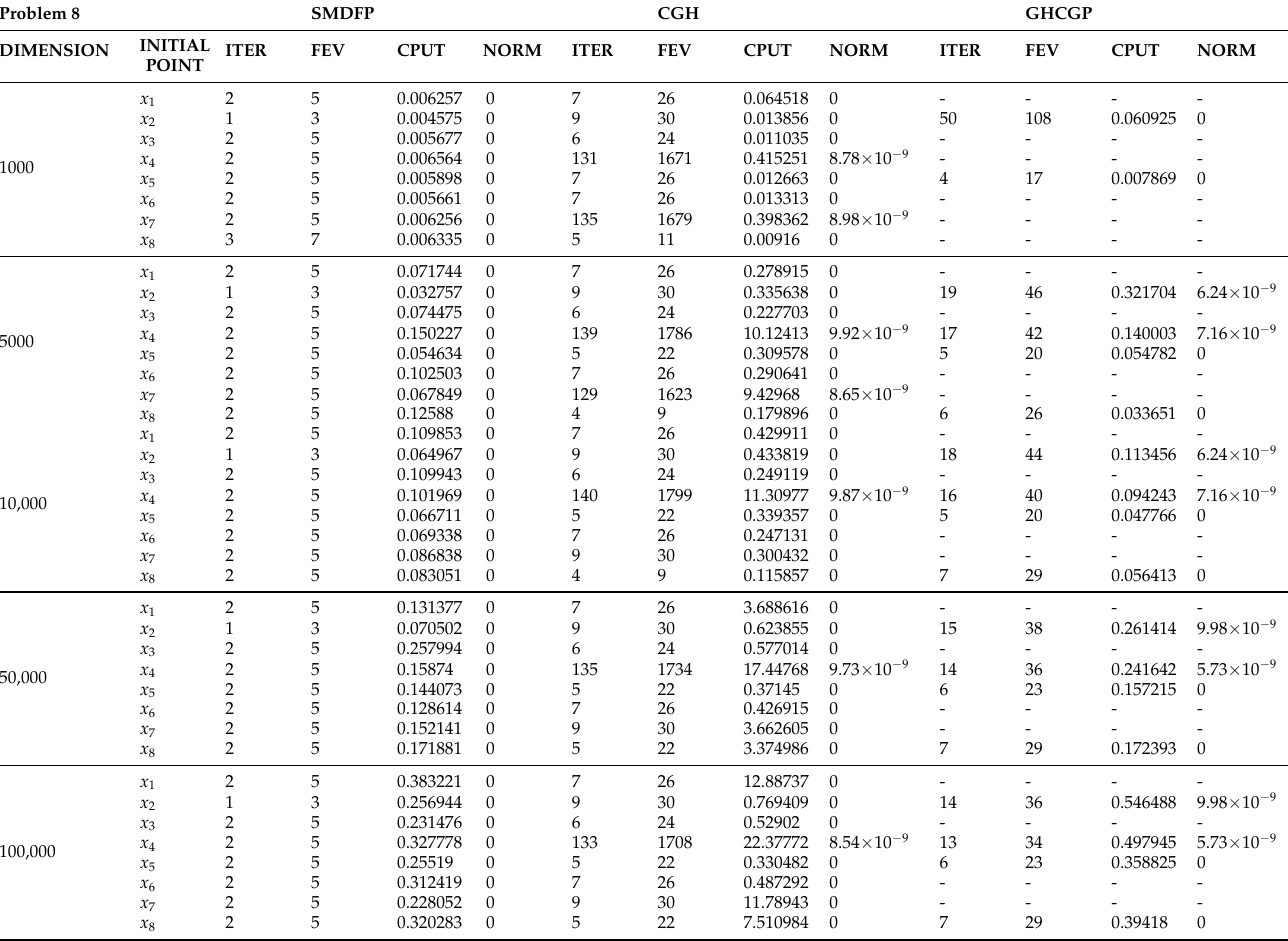
Table 8. Numerical comparison of the SMDFP, CGH [61], and GHCGP [62]